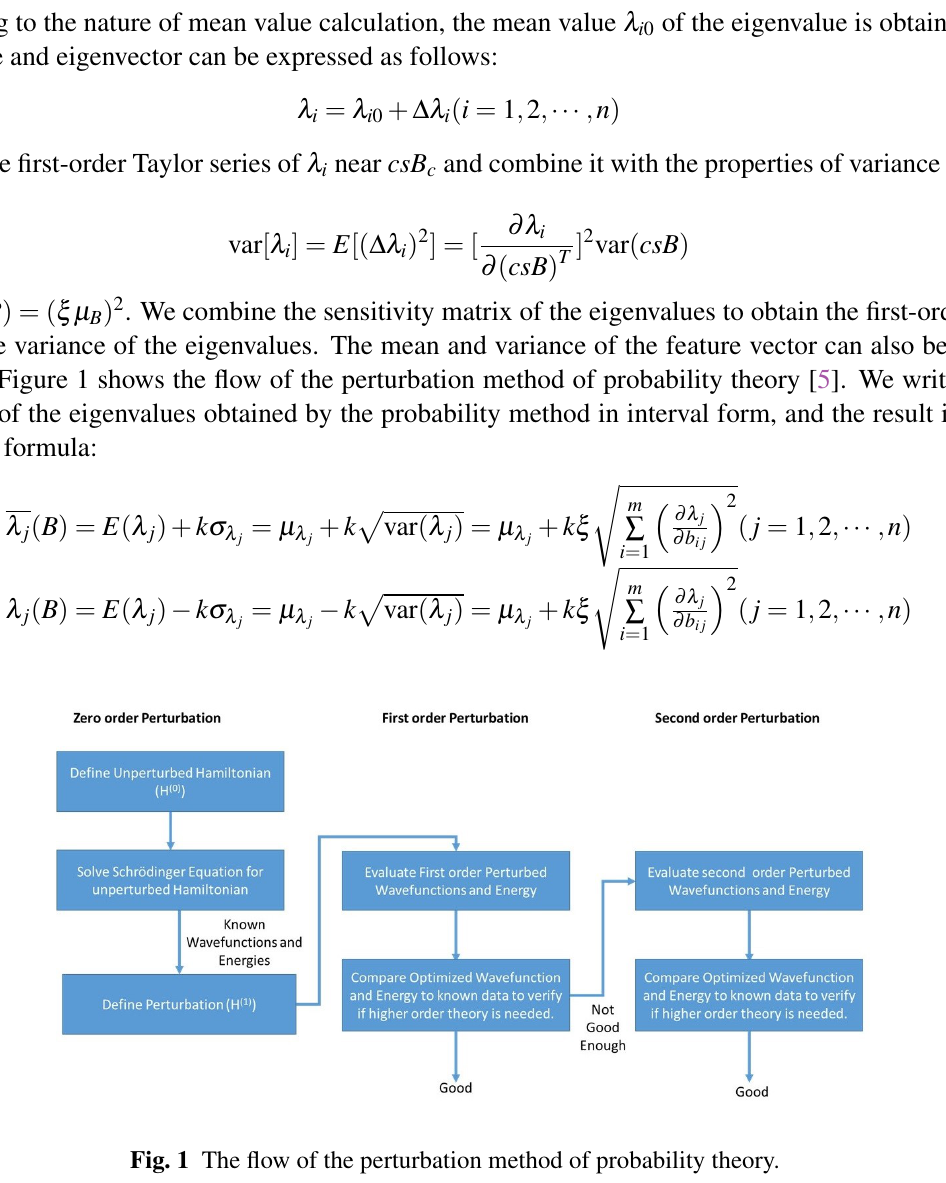
Fig. 1 The flow of the perturbation method of probability